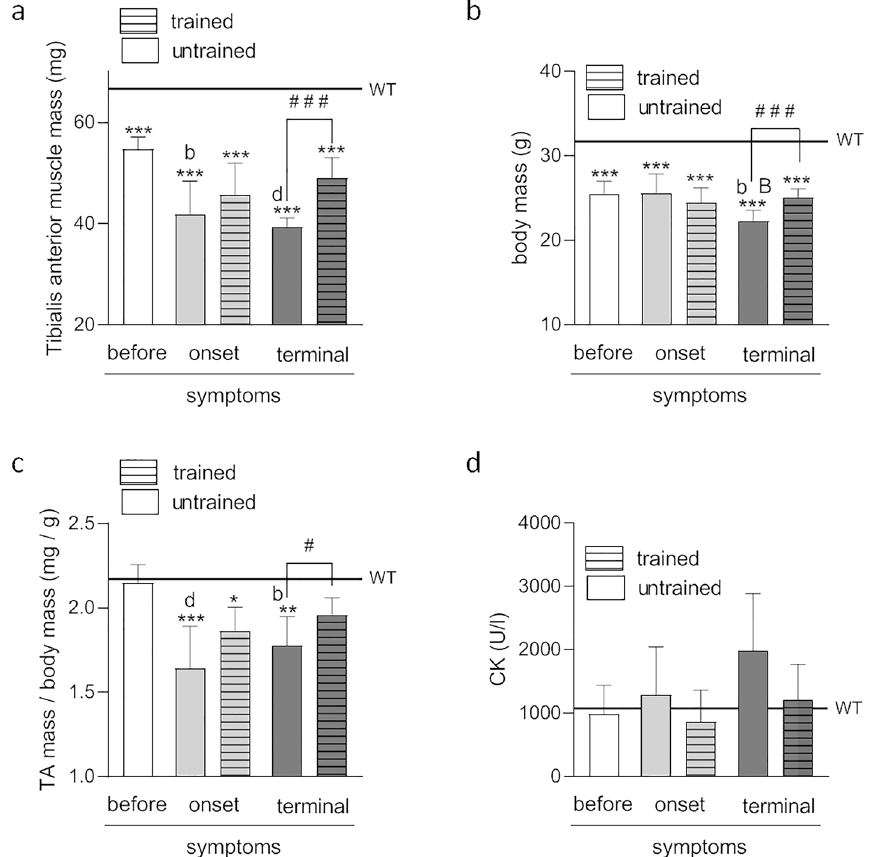
Figure 4. Effects of ALS disease progression and swim training on body mass, tibialis anterior muscle mass, and blood creatine kinase activity. Tibialis anterior muscle mass (a) body mass (b) , the ratio of tibialis anterior to body mass (c) , and activity of blood creatine kinase (d) in mice. There were significant differences between the groups: *p < 0.05, **p < 0.01, ***p < 0.001 vs. WT group of mice, # p < 0.05, ### p < 0.001 between indicated group, b p < 0.01, d p < 0.001 vs. BEFORE group, B p < 0.01 vs. ONSET group, The data are presented as the means ± SEM [n = 7 in each group (a,b,c) and n = 6 in each group